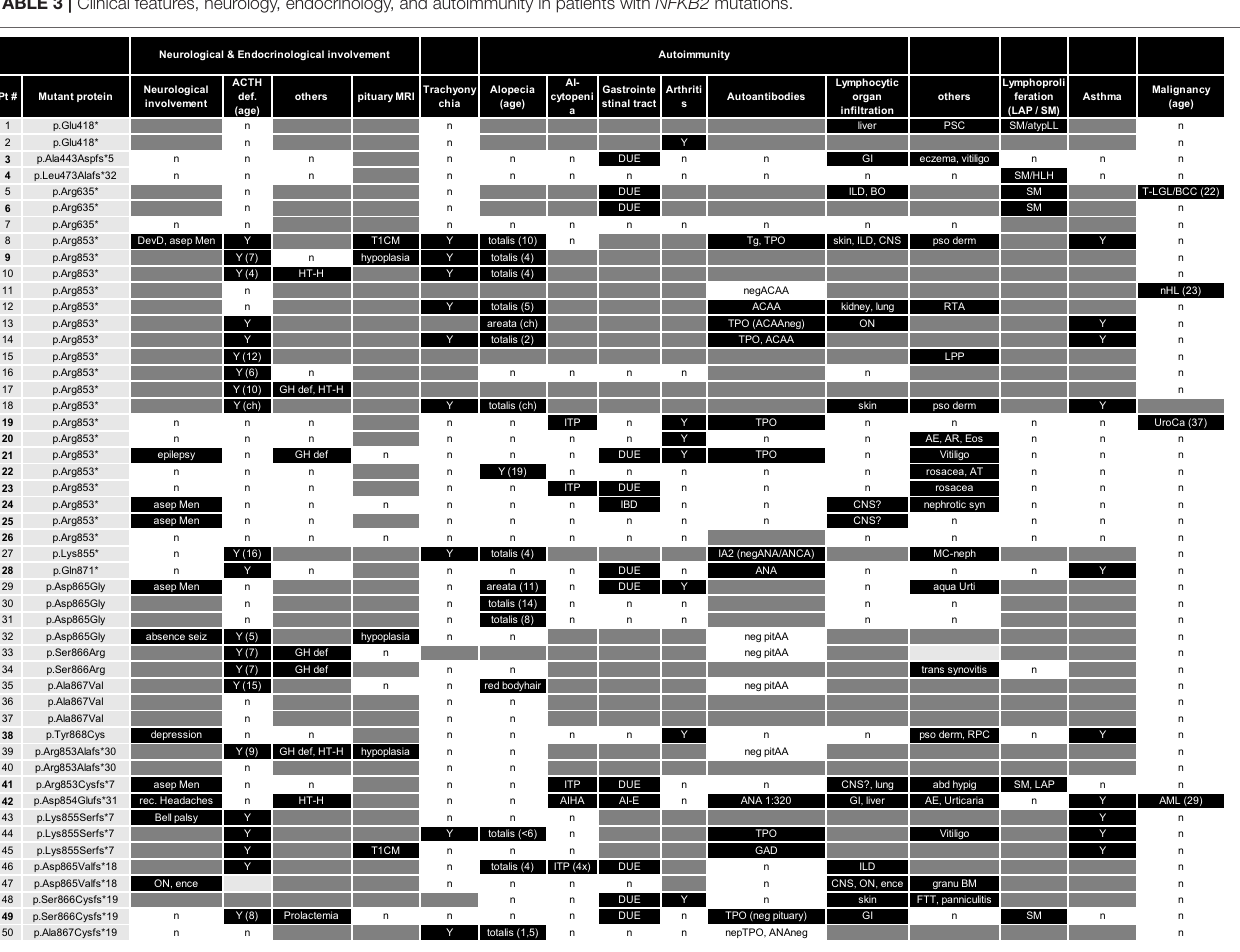
TABLE 3 | Clinical features, neurology, endocrinology, and autoimmunity in patients with NFKB2 mutations.